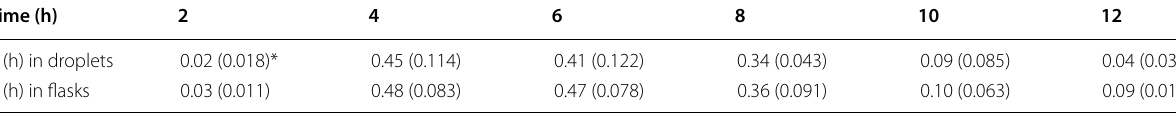
* Standard deviations are shown in